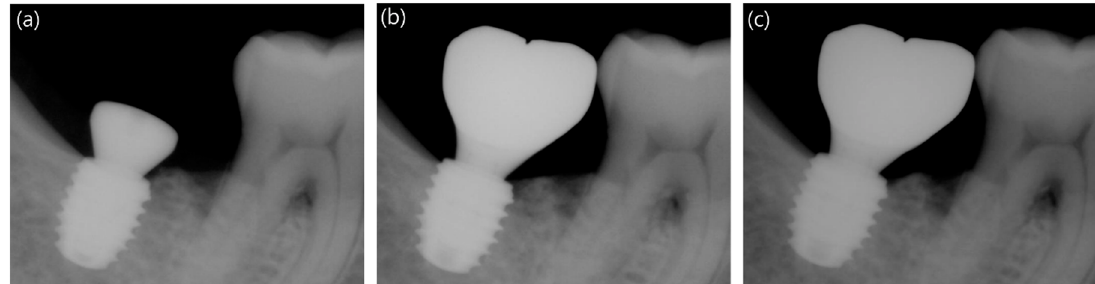
Figure 5. Standard periapical radiographs of implants placed in a patient in the experimental group (CMI IS-III active ® short implant, Neobiotech Co., Seoul, Korea): ( a ) at surgery, ( b ) at 12 weeks, and ( c ) at 48